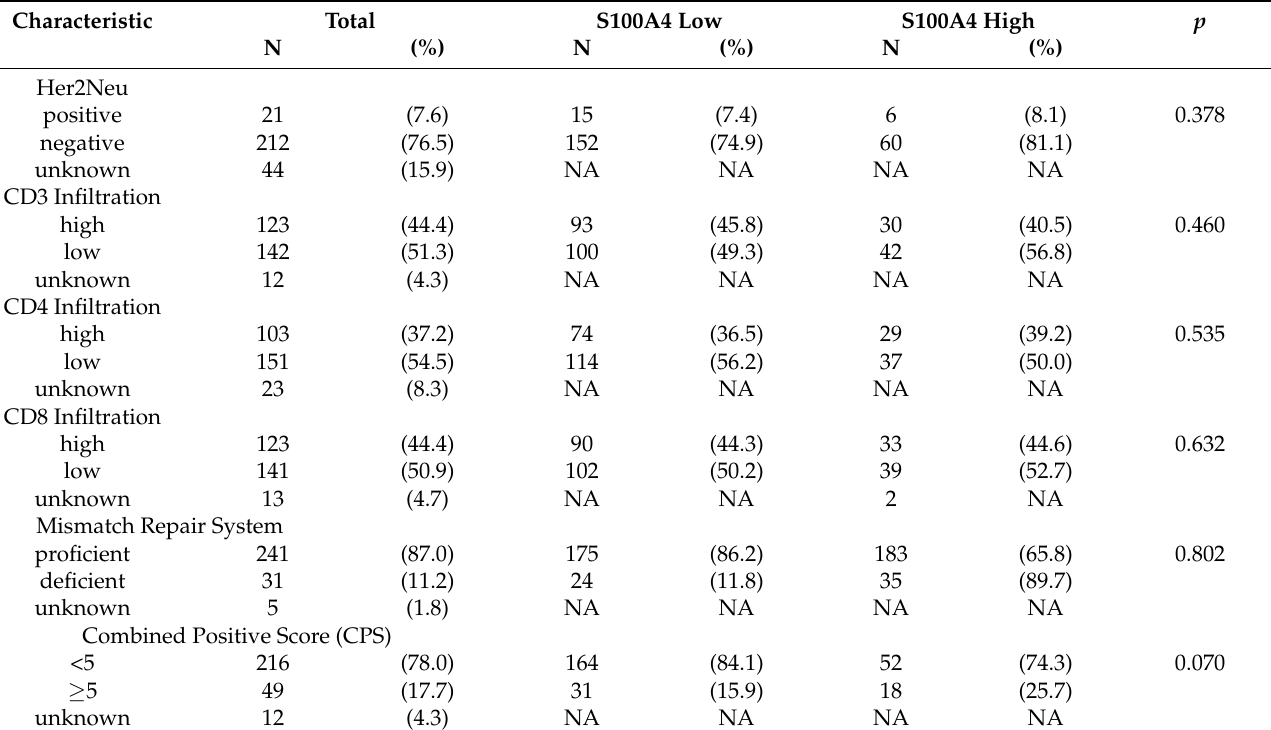
Table 3. Status of molecular characteristics markers of the analyzed patient cohort and distribution of S100A4 high and low tumors. Significance calculated by